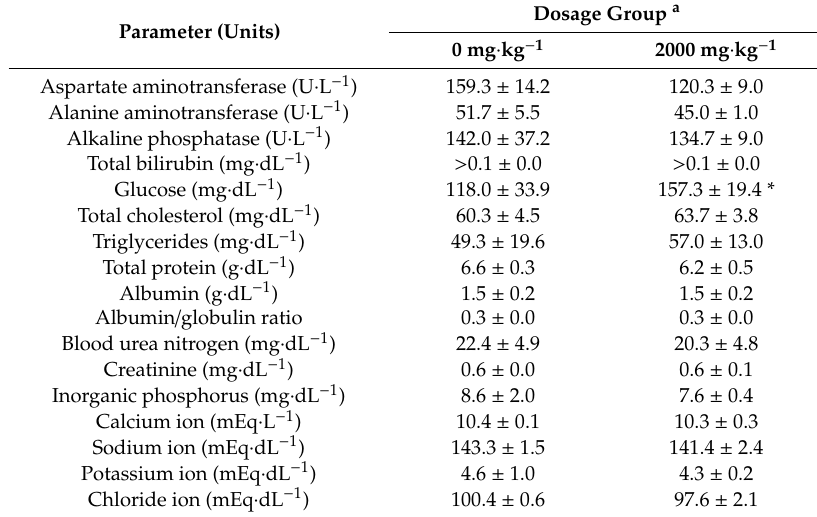
Table 5. Serum biochemical parameters in female rats, after 14 days of being exposed to a single dose (2000 mg · kg − 1 ) of a food-grade extract from avocado seed (Avosafe ® ), with an acetogenin purity of 94.74%.